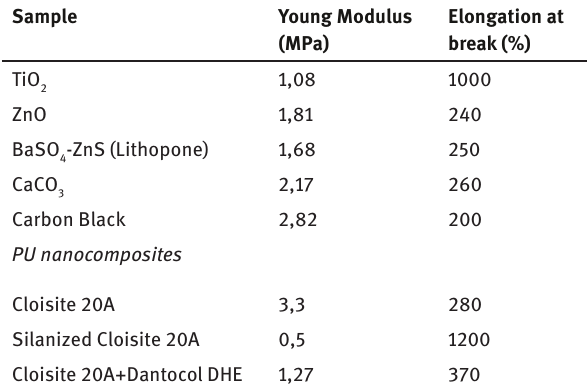
Table 1: Mechanical properties of microcomposites (PU) with different inorganic mineral fillers [20% (w/w)] and nanocomposites (NPU) with Cloisite 20A nanoclay [5% (w/w)].